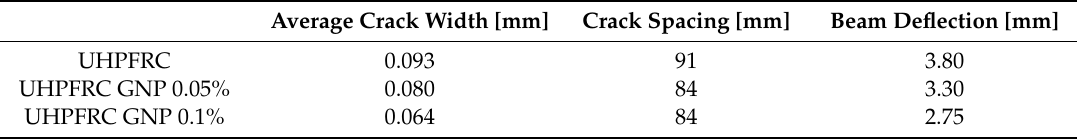
Table 4. Average crack width, crack spacing, and beam deflection of the simulated beams at a load level of 65